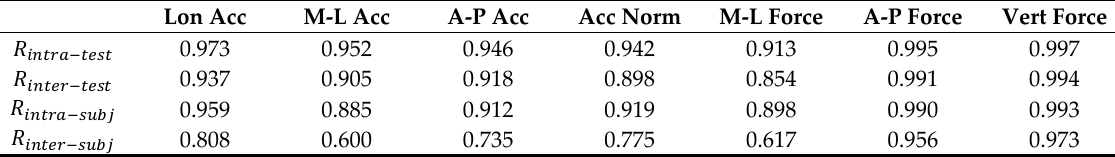
Table 1. Coefficient of multiple correlation for intra- and inter-subject and test repeatability for longitudinal acceleration (Lon Acc), medio-lateral acceleration (M-L Acc), antero-posterior acceleration (A-P Acc), acceleration norm (Acc Norm), medio-lateral force (M-L Force), antero-posterior force (A-P Force) and vertical force (Vert Force). Lon Acc M-L Acc A-P Acc Acc